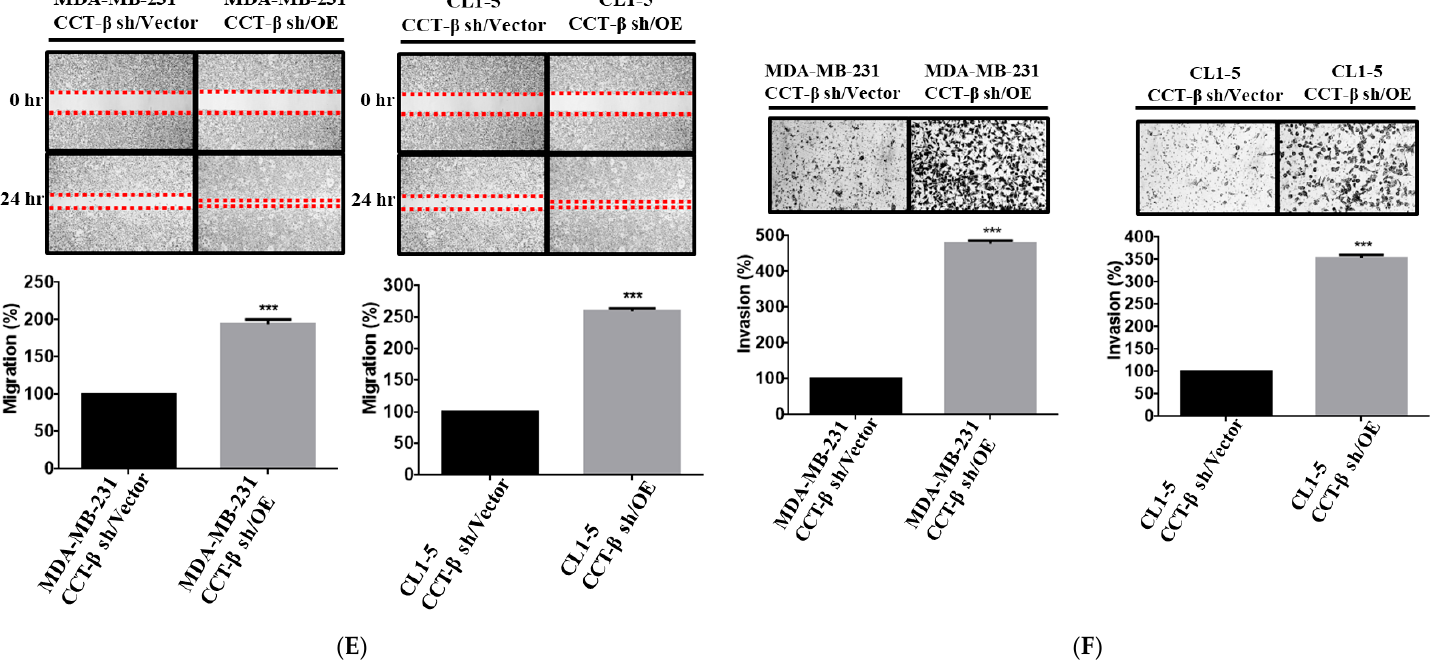
Figure 5. CCT- β knockdown inhibited MDA-MB-231 and CL1-5 cell migration/invasion. ( A , C ) Wound-healing assays of the MDA-MB-231 and CL1-5 cells with and without CCT- β silencing. Representative photos for cell migration from the wound edge (the red dotted lines) were captured under a microscope with a 4× objective, and the migratory areas were measured and analyzed using ImageJ software. Data are presented as the mean ± S.D. of three independent experiments. *** p < 0.001 vs. the control. ( B , D ) Transwell assays for MDA-MB-231 and CL1-5 cells with and without CCT- β silencing. Representative photos of the invasion were captured under a microscope with a 10× objective, and the areas of invaded cells were calculated. Data are presented as the mean ± S.D. of three independent experiments. *** p < 0.001 vs. the control. ( E ) Increased wound healing by overexpressing CCT- β in the CCT- β knockdown MDA-MB-231 and CL1-5 cells. ( F ) Transwell assays after overexpression of CCT- β in the CCT- β knockdown MDA-MB-231 and CL1-5 cells.